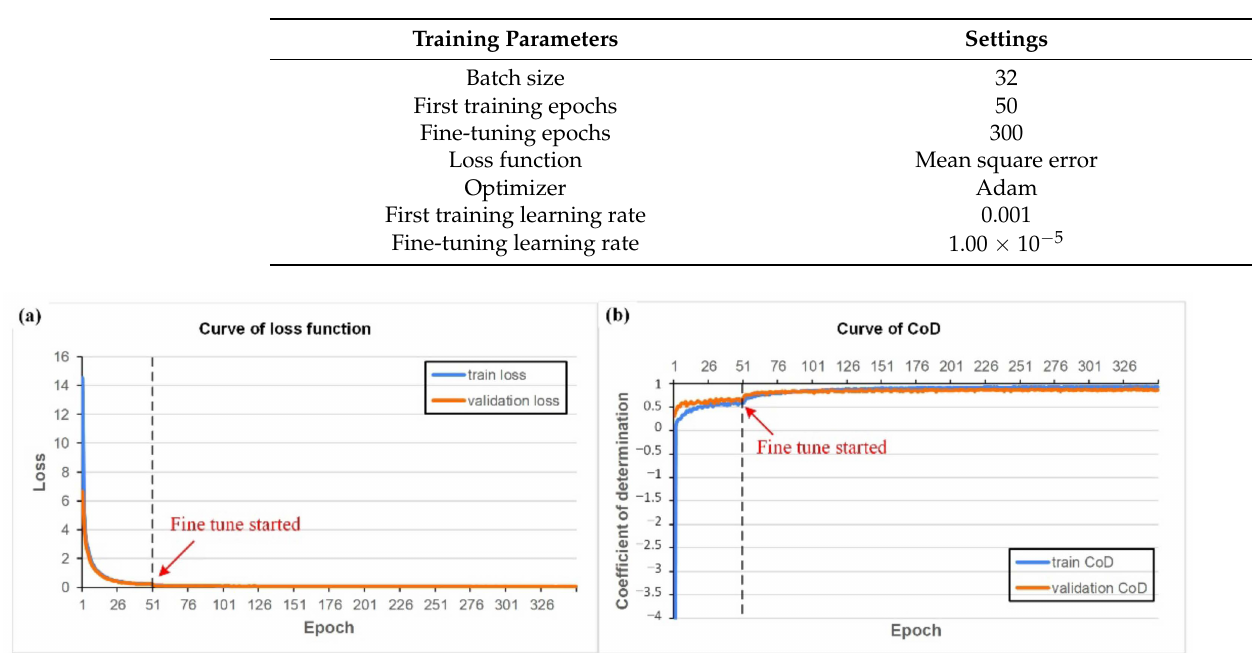
Table 6. The training parameters of the model of the second task: Estimation of the surface roughness of the workpiece.